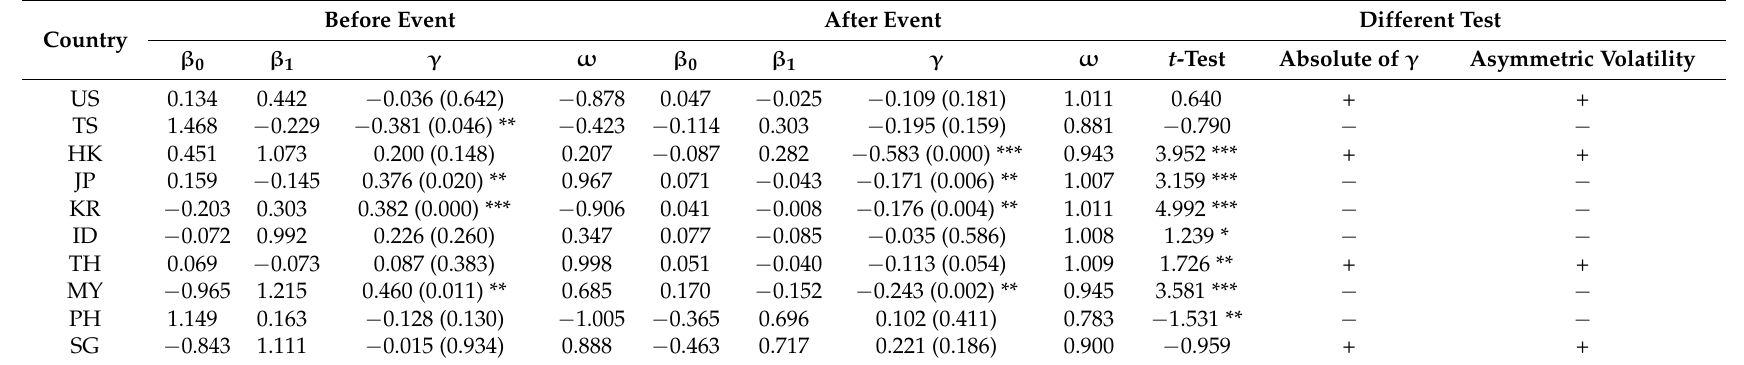
Table 13. The EGARCH model results: China’s Sichuan